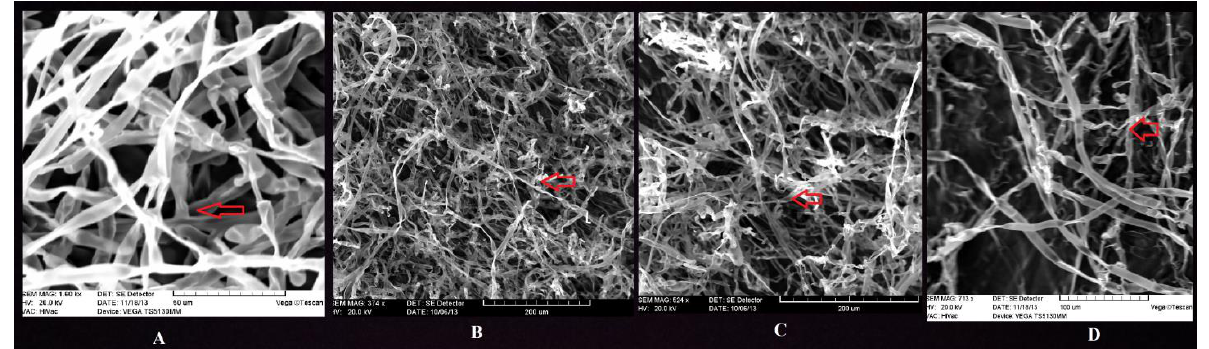
Figure 2. SEM images from the inhibition zone demonstrating the antagonistic behavior of Actino- mycetes isolates against Rhizoctonia solani . The arrows in the control image depict healthy, intact mycelia, whereas those in the other images reveal malformed, damaged R. solani hyphae. Control, isolate U, isolate No. 5, and isolate G, respectively, are shown in ( A – D ).